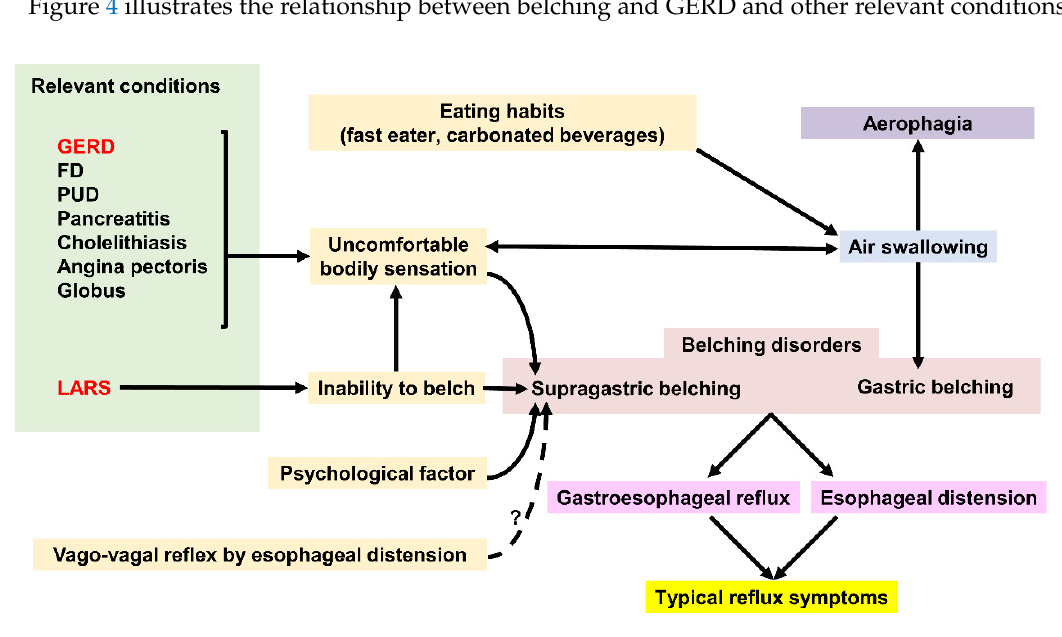
Figure 4. Factors affecting Gastric belching and Supragastric belching. GERD; gastroesophageal reflux disease, FD; functional dyspepsia, PUD; peptic ulcer disease, LARS; laparoscopic anti-reflux surgery.